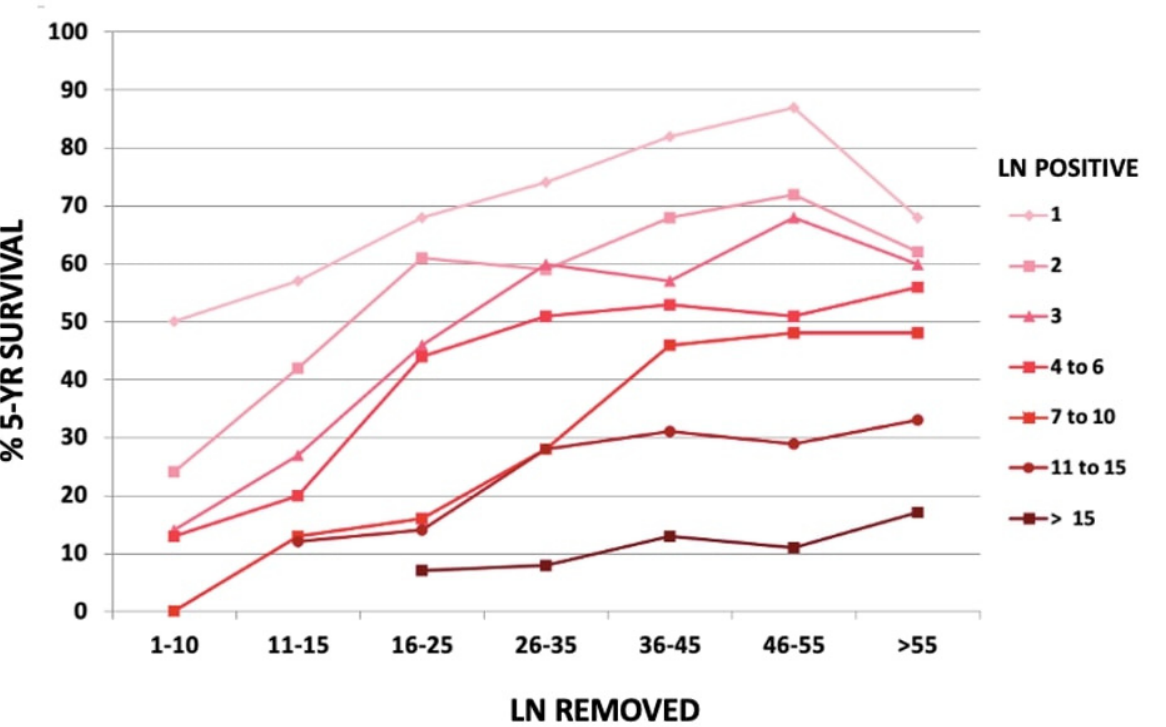
Figure 3. Five-year overall survival according to the number of removed nodes in different node positive subgroups, in GIRCG cohort.